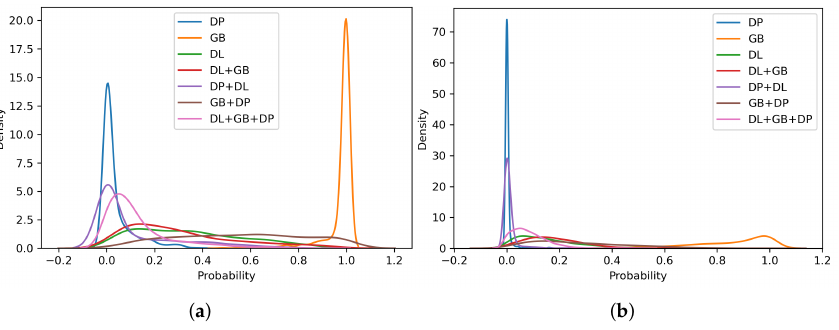
Figure 14. Probability distributions of ( a ) real and ( b ) fake fingerprint scores of the Biometrika 2013 dataset obtained by the PAD Spoofbuster.